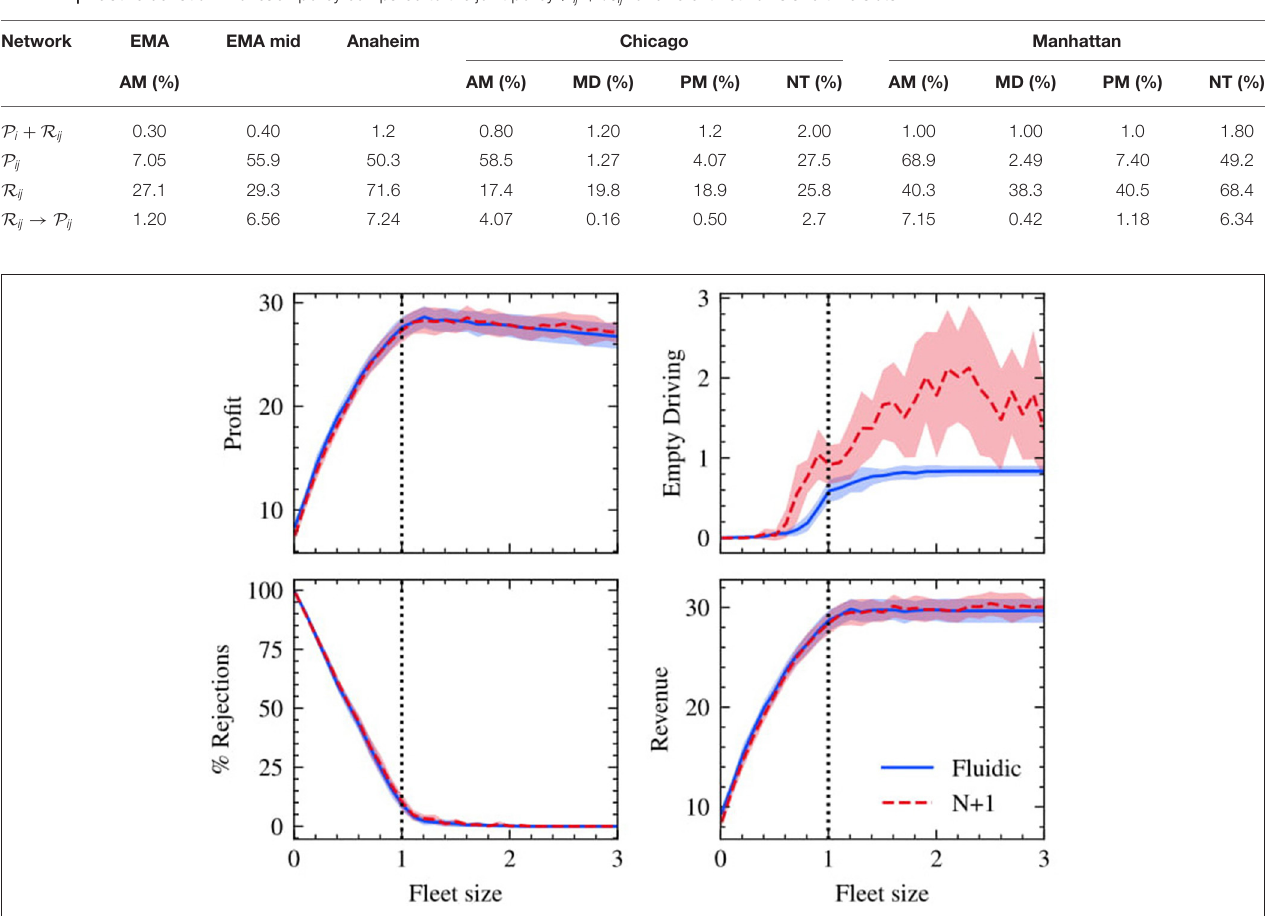
FIGURE 6 | Performance indicators for different fleet sizes. Upper left plot shows the expected profit per minute. The upper right plot shows the percentage of time that vehicles are rebalancing. The lower left shows the percentage of customer requests that were rejected because there were no available vehicles to serve the customer. Finally, the lower right plot shows the revenue per